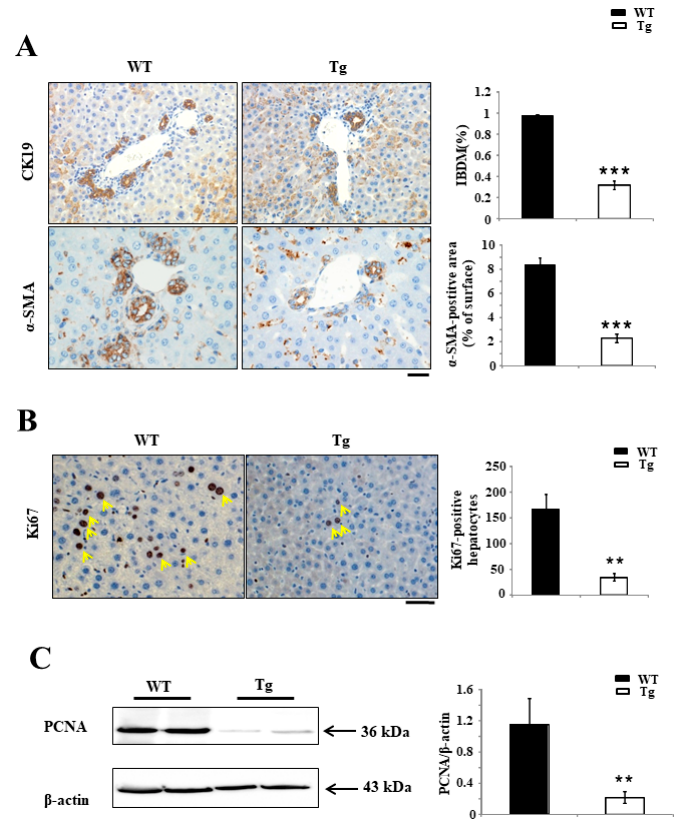
Figure 5. Measurements of intrahepatic bile duct mass (IBDM) and the analysis of proliferating hepatocytes in BDL ‐ induced cholestatic liver of mice. ( A ) IBDM composed of cytokeratin 19 (CK19) bile ducts was significantly smaller in hPRDX4 ‐ Tg mice at day 7 after BDL surgery than in WT mice. Similarly, IHC of day 7 BDL hPRDX4 ‐ Tg mice livers revealed a significantly lower expression of α‐ smooth muscle actin ( α‐ SMA) along the hyperplastic bile than in WT mice. ( B ) The number of Ki67 + hepatocytes was significantly lower in hPRDX4 ‐ Tg mice at day 7 after BDL surgery than in WT mice. Arrows, positive cells. ( C ) Corresponding to the histologic data, a Western blotting analysis revealed that the expression of proliferating cell nuclear antigen (PCNA) in livers of hPRDX4 ‐ Tg mice at day 7 after BDL surgery was significantly lower than in WT mice. Because the aberrant regeneration (proliferation) of hepatocytes is closely related to the extent of liver injury, we can conclude that the overexpression of PRDX4 suppressed the proliferative activity of hepatocytes and thereby protected the liver from injury. p Values were calculated using Welch’s t ‐ test. The values represent the mean ± SD. Bar = 100 µm. ** p < 0.001, *** p < 0.0001, n = 15.